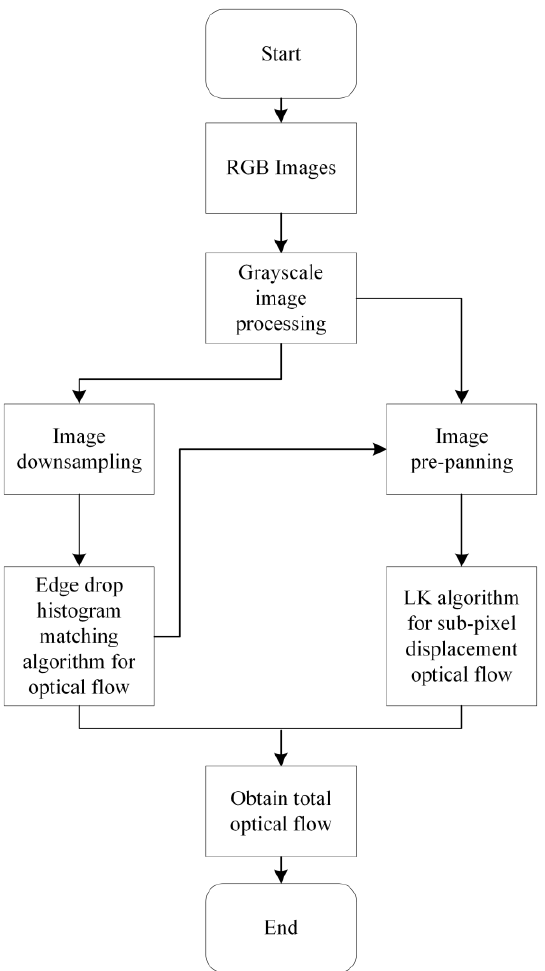
Figure 2. Flowchart of large-displacement optical-flow based on edge-histogram matching.